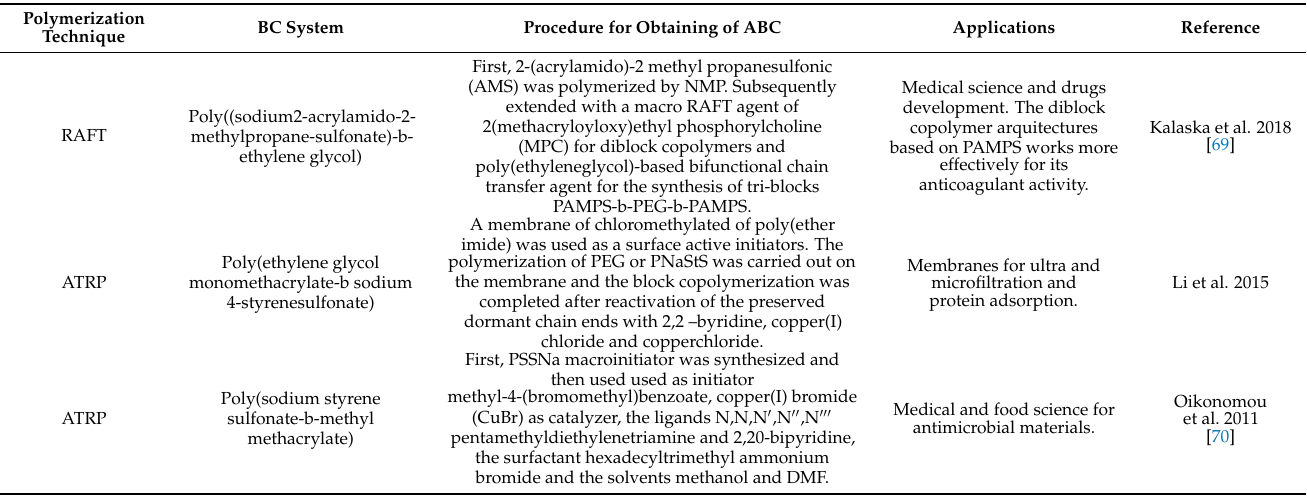
Table 1. List of recent works published in the last decade that employed one sulfonated monomer to the obtention of the BC.